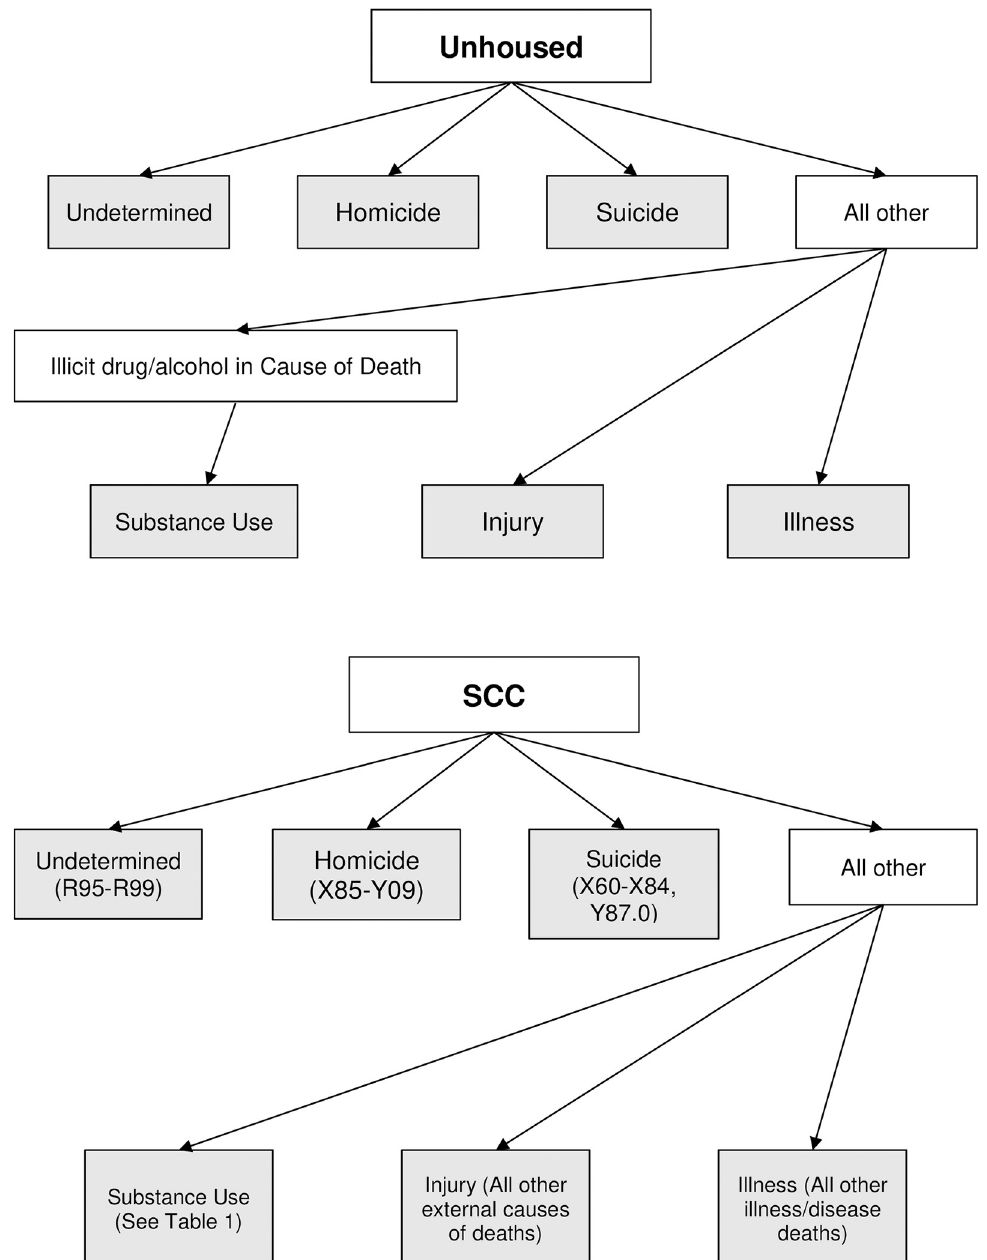
Fig 1. Categorization of causes of death for the unhoused cohort and the Santa Clara County general population.